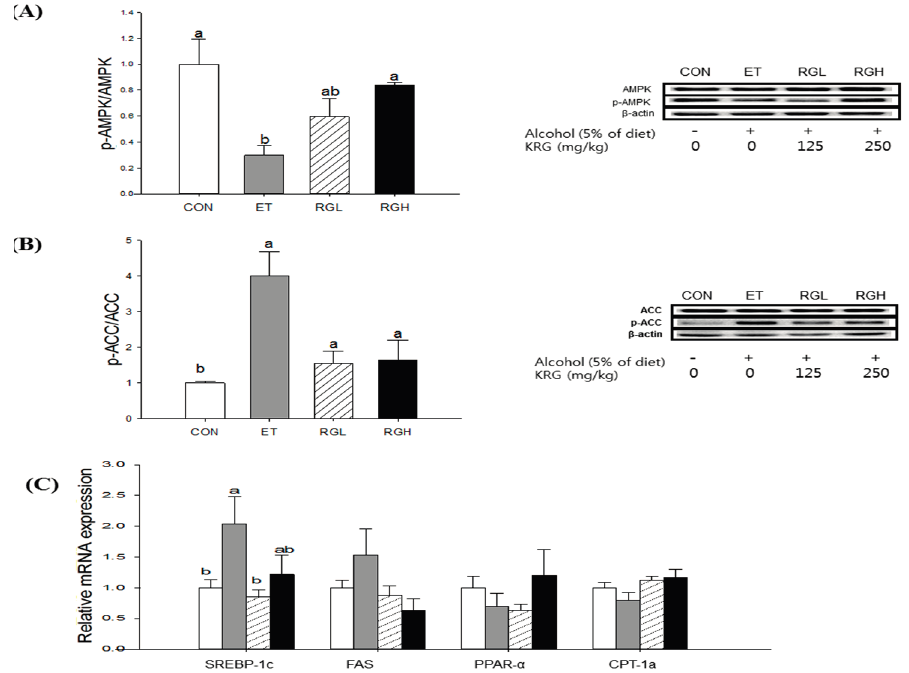
Figure 4. Protein phosphorylation and mRNA expression in the liver of rats fed alcohol and KRG for 6 weeks. ( A ) AMPK phosphorylation; ( B ) ACC phosphorylation; and ( C ) mRNA expressions of SREBP-1c, FAS, PPAR- α and CPT-1a. CON, normal control; ET, alcohol control; RGL, alcohol + 125 mg/kg KRG; RGH, alcohol + 250 mg/kg KRG. Alcohol was provided at 5% of the Lieber-DeCarli liquid diet, and KRG was administered daily by gavage for the same time period. Data are expressed as the means ± SE ( n = 10/group). The values with the different letters are significantly different based on Duncan’s multiple range tests, p =